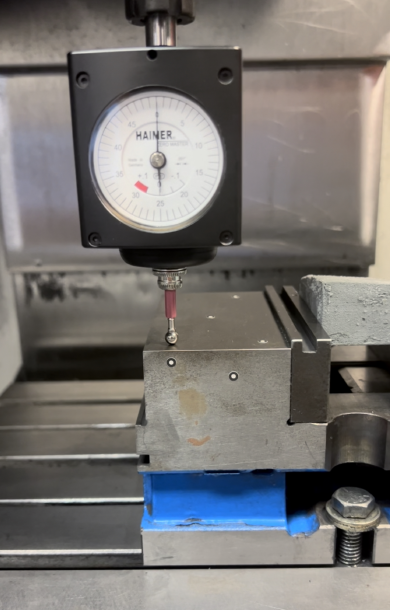
Figure 7. Probing of top surface to find WCS Z zero in the milling machine